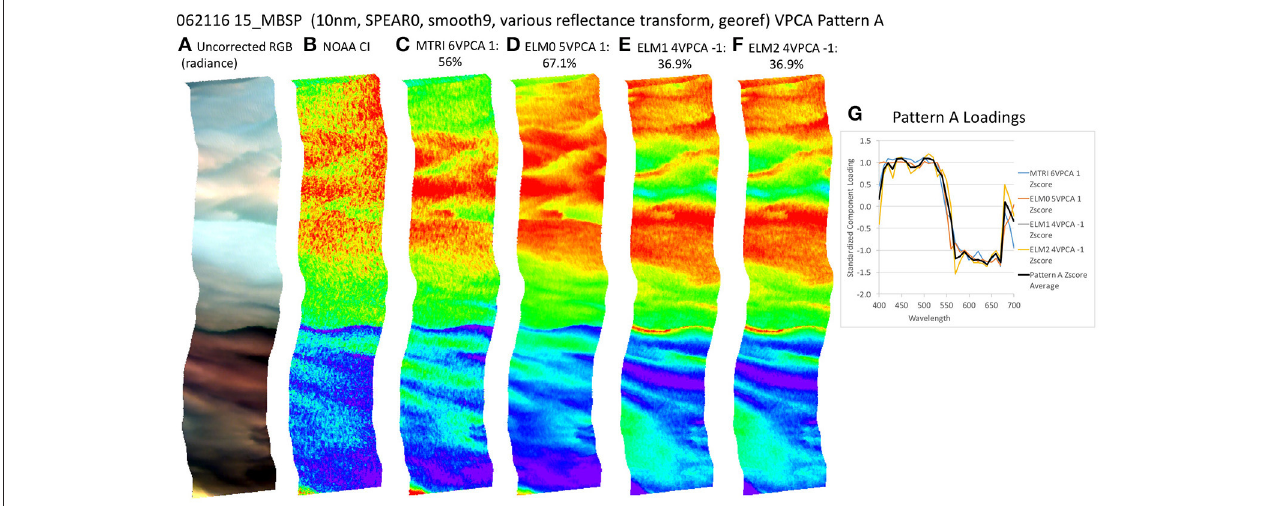
FIGURE 8 | (A) Red, Green, Blue (RGB) image of swath 15_MBSP from June 21, 2016. (B) National Oceanic and Aeronautical Administration Cyanobacterial Index (NOAA CI) product calculated after Wynne et al. (2010). (C) Spatial distribution of varimax-rotated principal component analysis (VPCA) component pattern A using